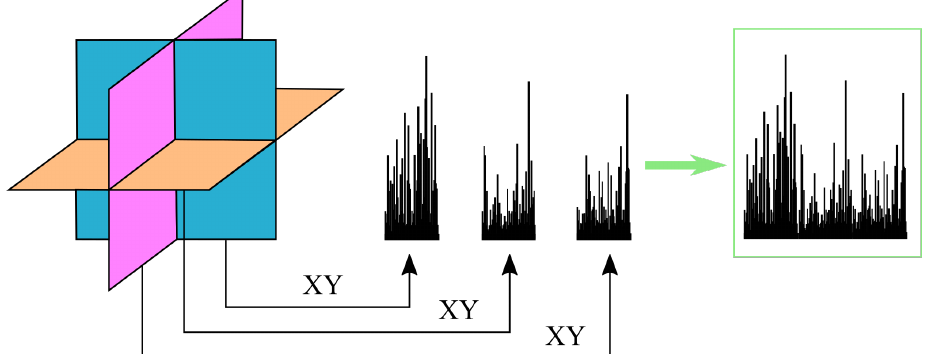
Figure 5. Conceptual illustration of the Histogram of Concatenated Local Binary Patterns on Three Orthogonal Planes (LBP-TOP)